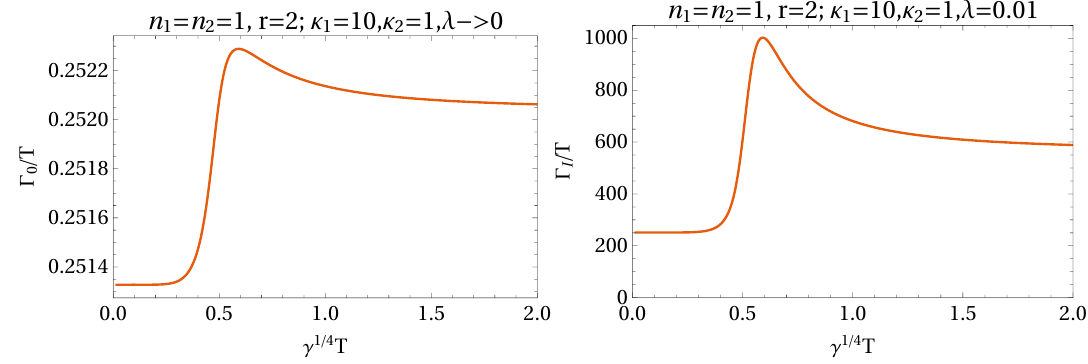
Figure 14 . Pure damping modes (identical in shear sector and sound sector). Left panel: damping constant (cid:0) 0 that remains (cid:12)nite when (cid:21) ! 0; right panel: damping constant (cid:0) I of the Israel-Stewart relaxational mode which is large for small (cid:21) (however, (cid:21) cannot be made arbitrarily small at large (cid:13) 1 = 4 T , see